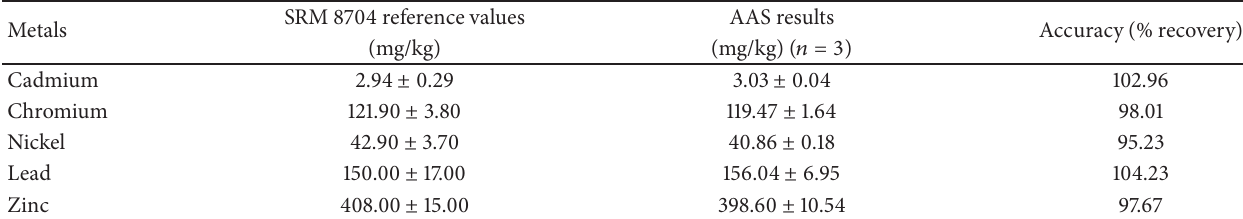
Table 1: Reference (SRM 8704) concentration values, analytical results, and percentage